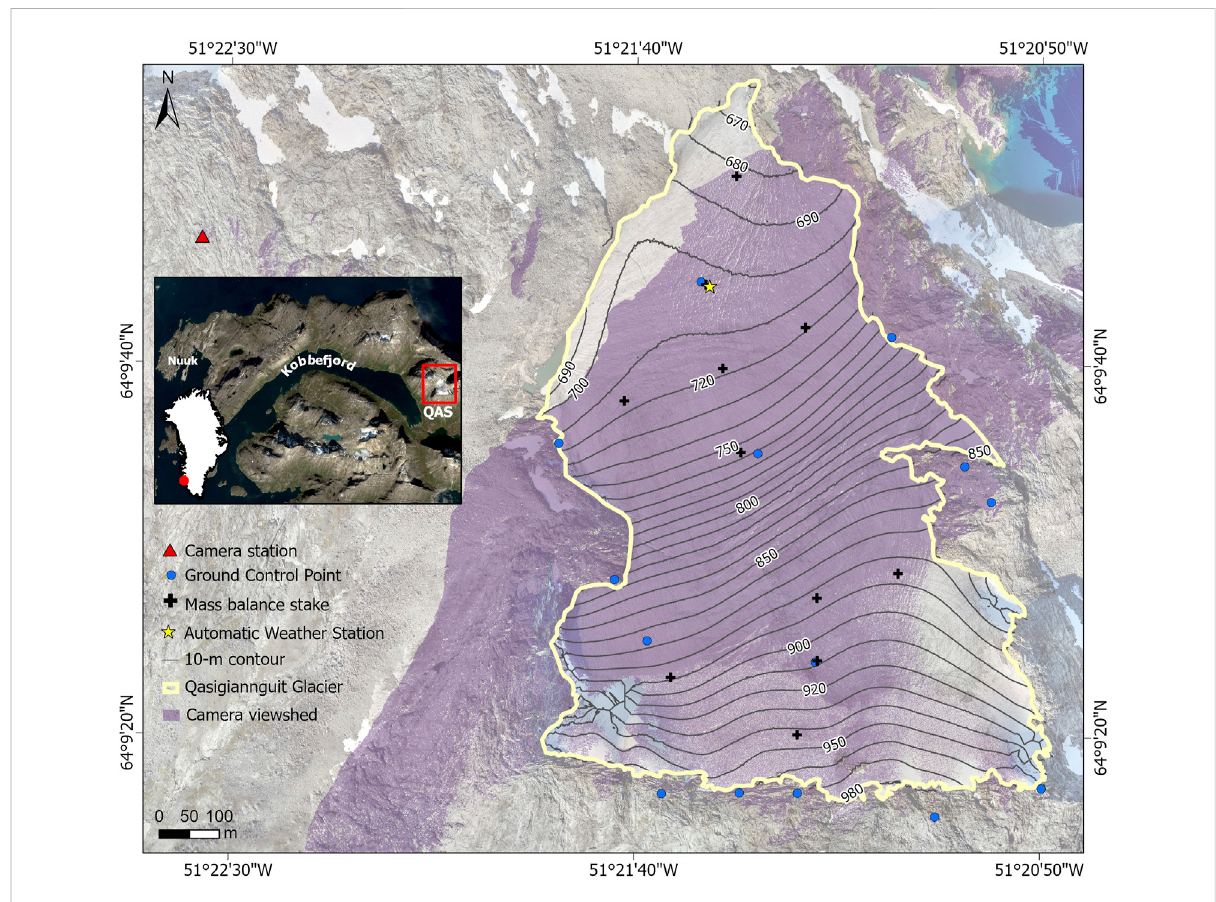
FIGURE 1 Map of Qasigiannguit glacier showing locations of time-lapse camera station and ground control points. Purple areas show the camera viewshed. The location of the automatic weather station is marked with a star. Base image is an orthophoto from a September 2020 drone survey.